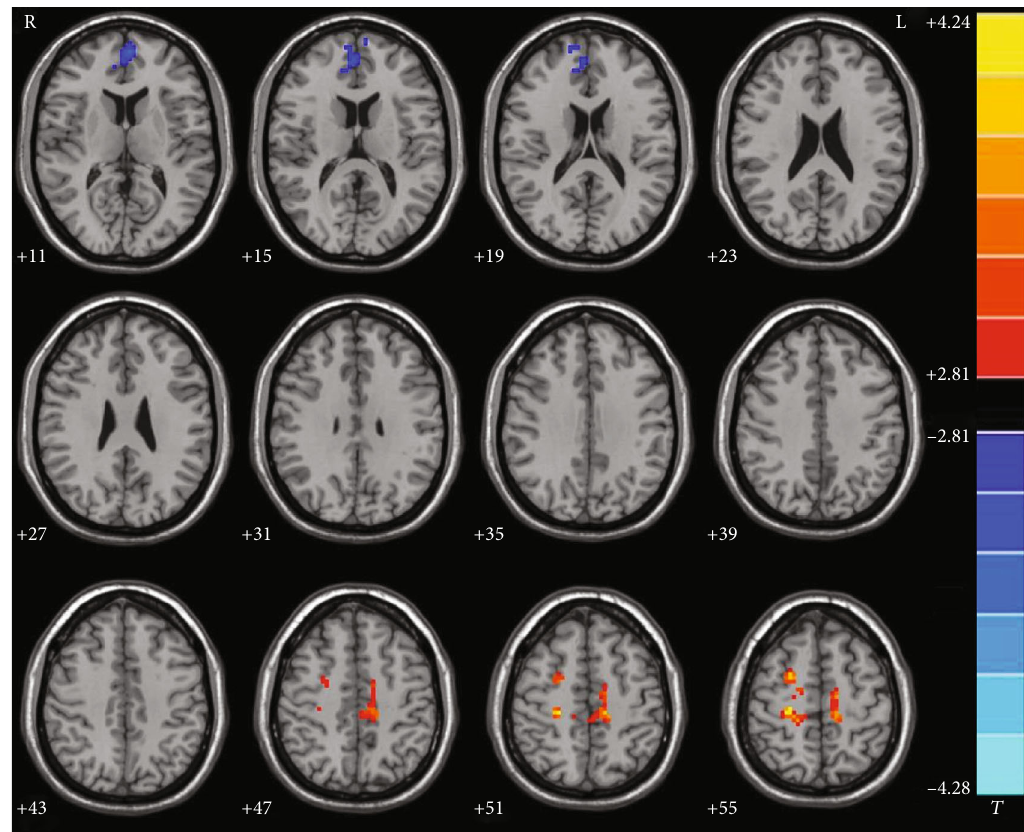
Figure 1: Abnormal GFC in patients with BSP relative to healthy controls. GFC: global-brain functional connectivity; BSP: primary